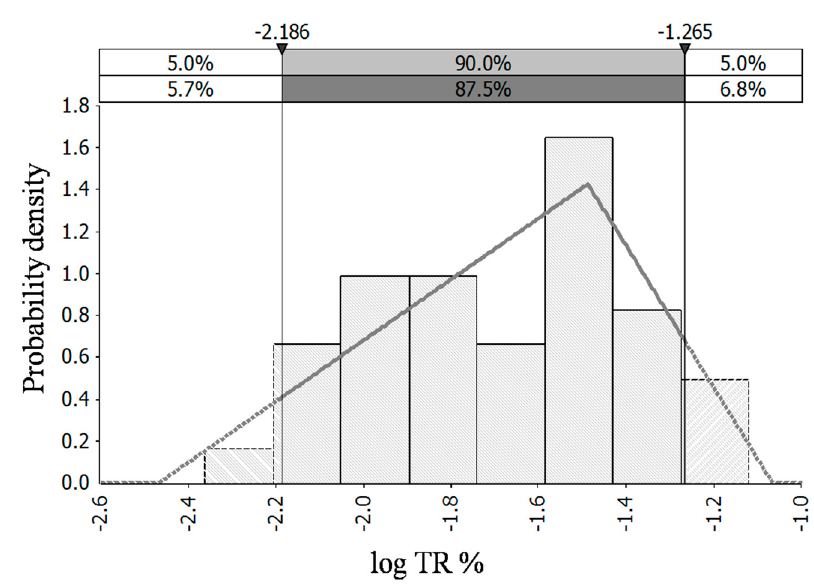
Figure 3. Probability distribution of transfer rate (log%) among chicken breasts in chilling water with 50–100 mg/L of chlorine.